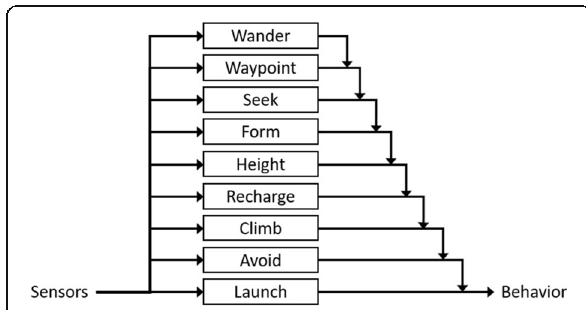
Fig. 2 Standard method behavior set